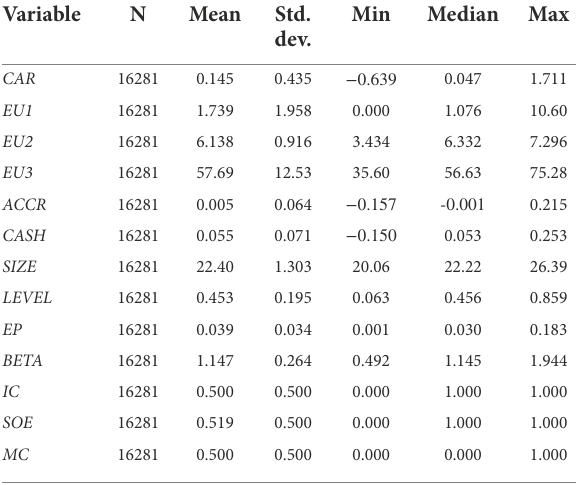
TABLE 2 Descriptive statistics of major